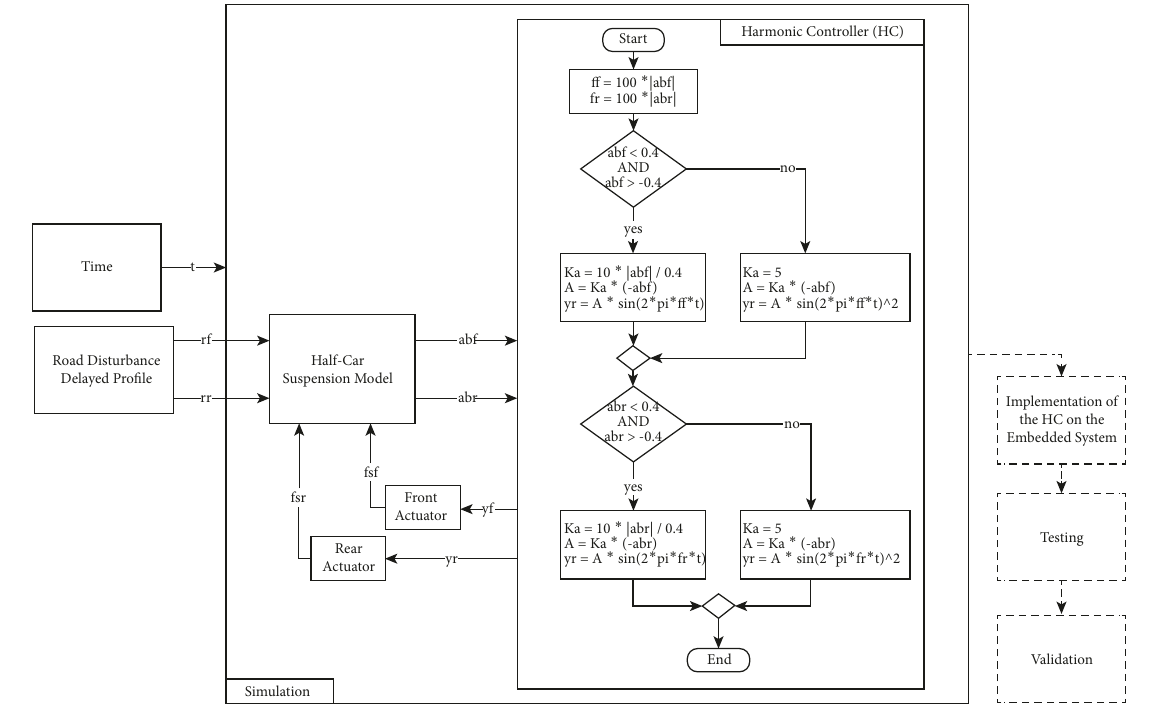
Figure 3: Detailed design process of the adaptive harmonic controller.